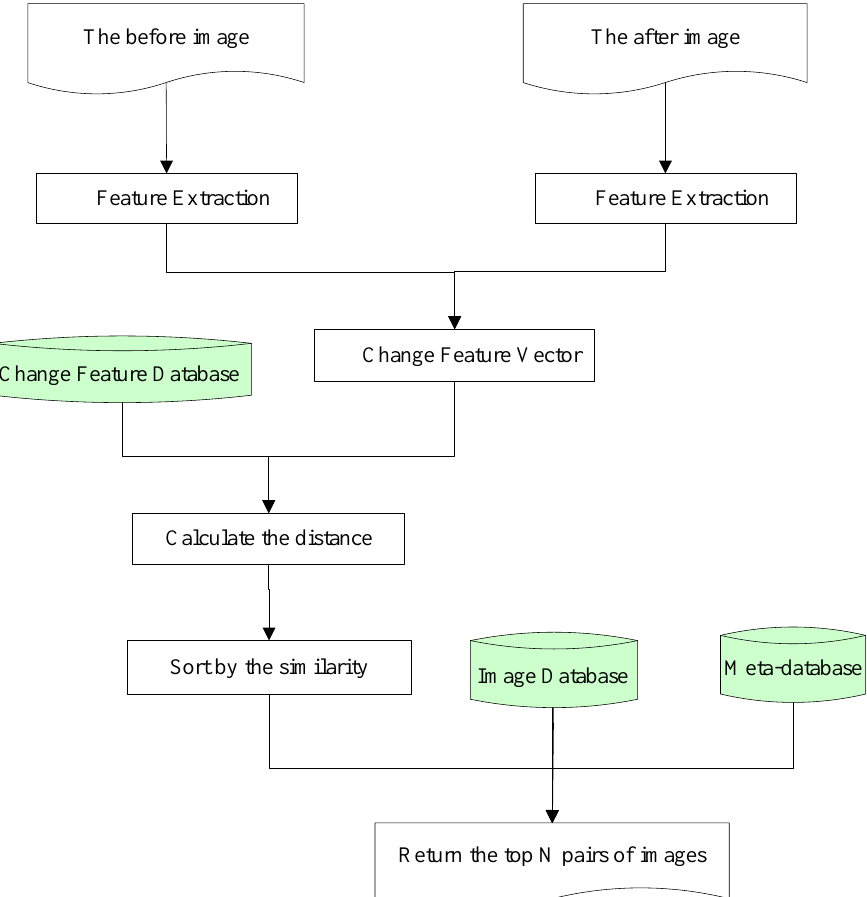
Figure 4. The architecture of the content-based remote sensing image change information retrieval Figure model.